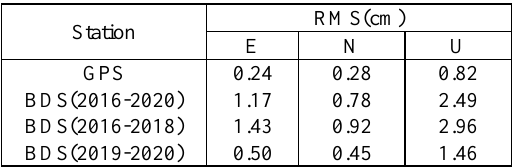
Table 4. RMS of time series residual of coordinates of stations AHBZ after elimination of linear